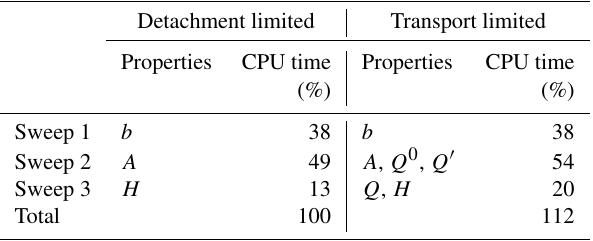
Table 1. Time complexity of the scheme for transport-limited ero- sion compared to the implicit scheme for detachment-limited ero- sion. CPU time was normalized to the total effort of one time step for detachment-limited